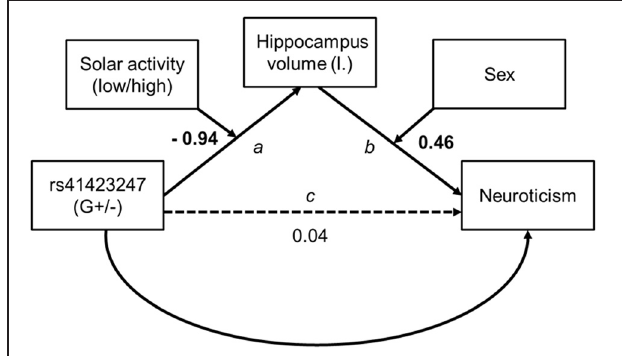
FIGURE 5 | Conditional model tested for indirect effects from genetics on personality. Unstandardized path coefficients are shown. On path a and b the coefficients refer to the interaction term. Bold figures are significant ( p < 0 . 01).